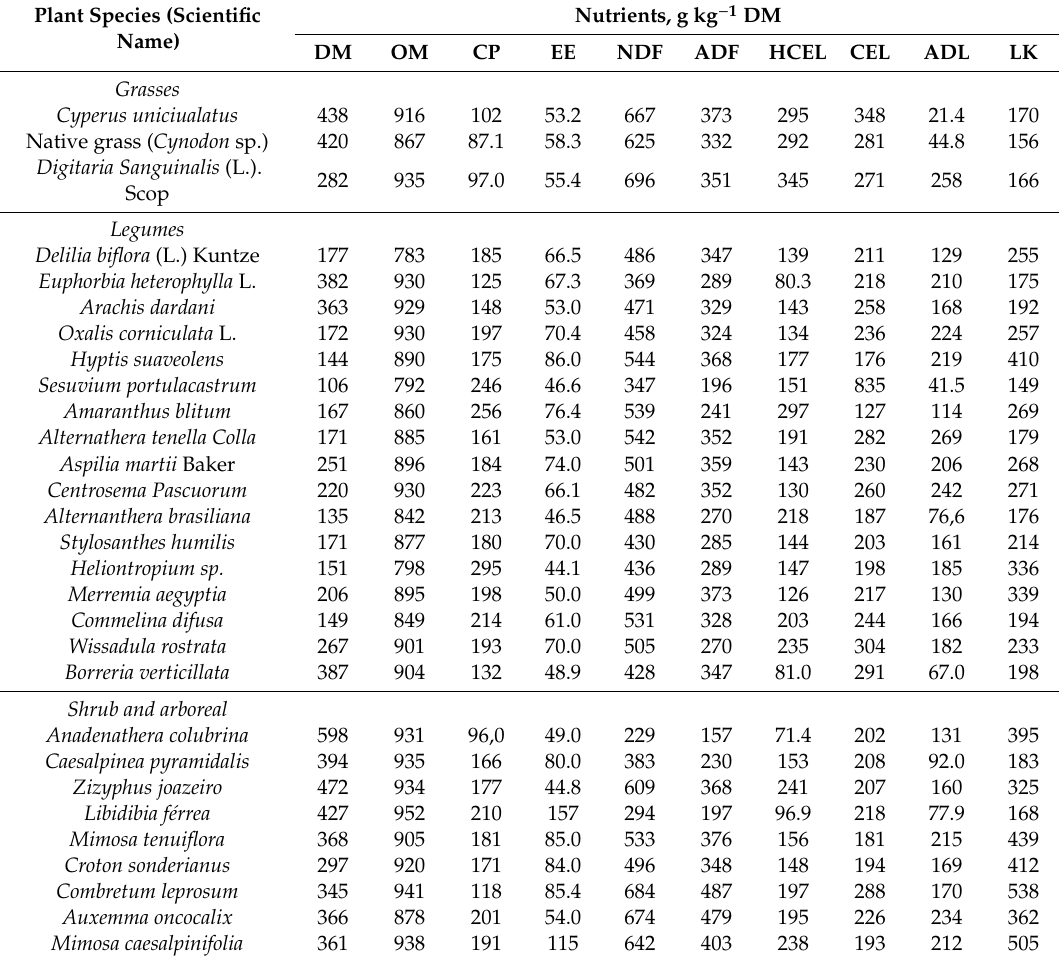
Table 3. Bromatological composition of Caatinga -native pasture during the rainy season. Plant Species (Scientific